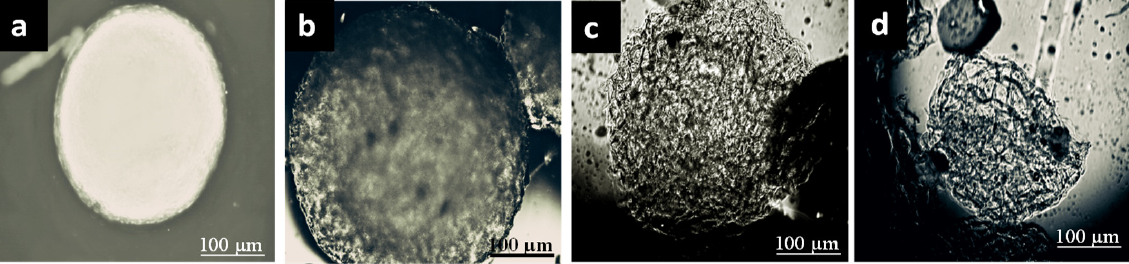
Figure 2. Optical images of insulin-loaded AX microcapsules during transit in the simulated stom- ach ( a ), small intestine ( b ), and ascending colon after 6 h ( c ) and 12 h exposure ( d ). 2.3. In Vitro Insulin Release The insulin release profile of the AX microcapsules was examined in a pH range of 1.2–7.4, to reflect GI pH conditions (Figure 3). In SGF, AX microcapsules released about